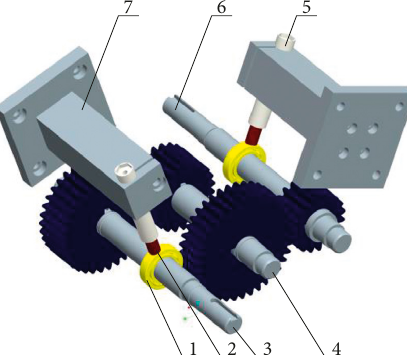
Figure 2: A detailed view of the internal structure of active control. (1) Support bearing. (2) Antiloading rod. (3) Output shaft. (4) Intermediate shaft. (5) Piezoelectric actuator. (6) Input shaft. (7) Actuator